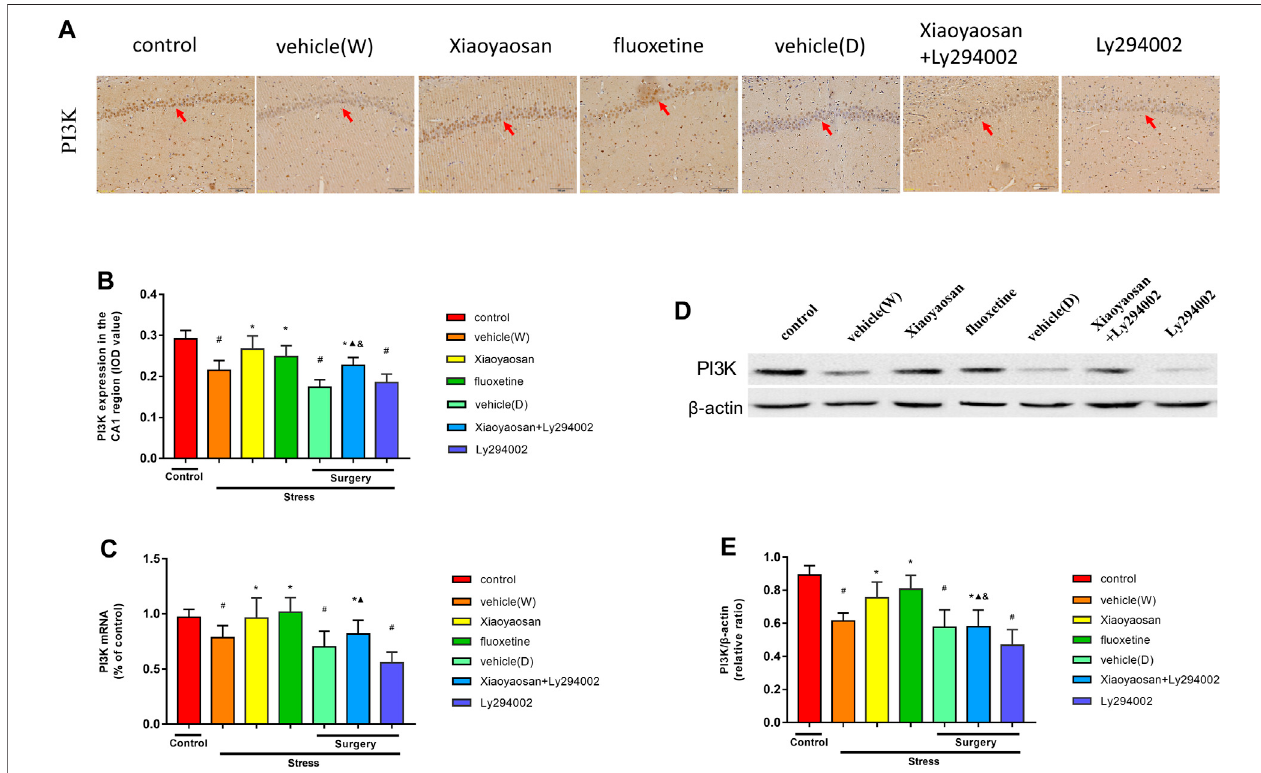
FIGURE 7 | Xiaoyaosan elevates the expression of PI3K in the hippocampal CA1 region of CUMS rats (A) Representative micrographs of immunohistochemical staining (sections were counterstained with hematoxylin; original magni fi cation, × 200) and (B) quantitative analysis showing the expression of PI3K in the hippocampal CA1 region (C) Level of PI3K mRNA in the hippocampal CA1 region (D) Representative images and western blot analysis (E) of western blot assay showing the relative expressionofPI3KinthehippocampalCA1region.Alldataareexpressedasthemean ± SD.# p < 0.05comparedtothecontrolgroup;* p < 0.05,comparedtothe vehicle (W) group; ▲ p < 0.05 compared to the Ly294002 group; & p < 0.05 compared to the Xiaoyaosan group, n (cid:2)